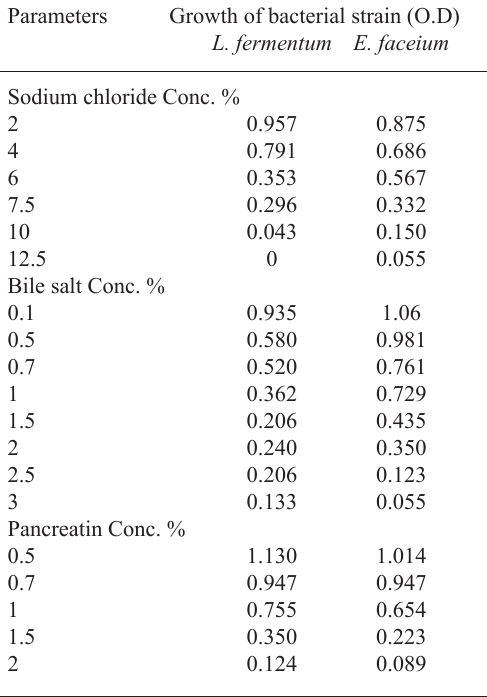
Table 3. Characteristics needed for LAB strains to